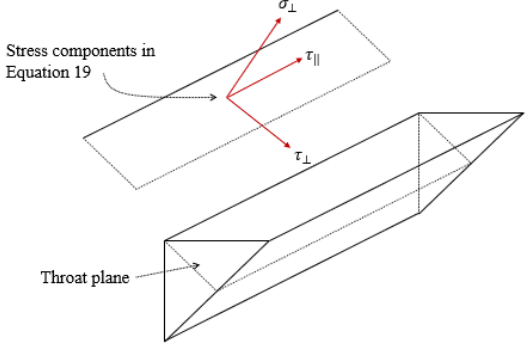
Figure 18. Stress components of Equation (19).